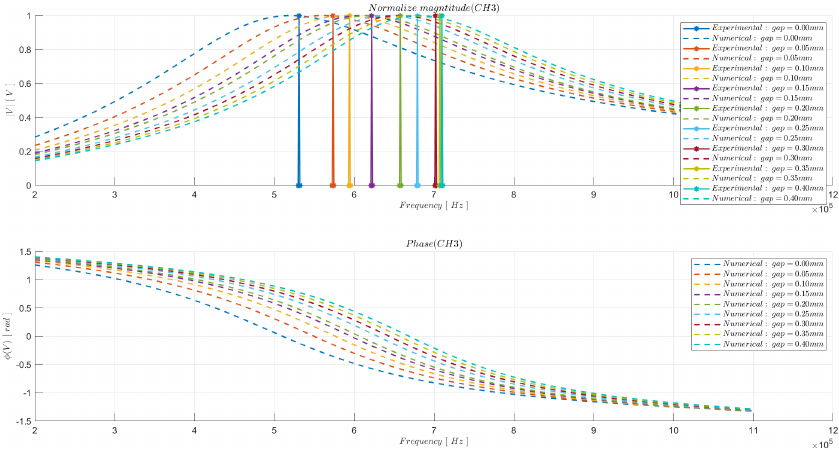
Figure 15. CH3 normalized numerical vs. experimental frequency response in an excitation range of [0.2; 1.1] MHz and an imposed gap variation from 0.00 mm to 0.40 mm.